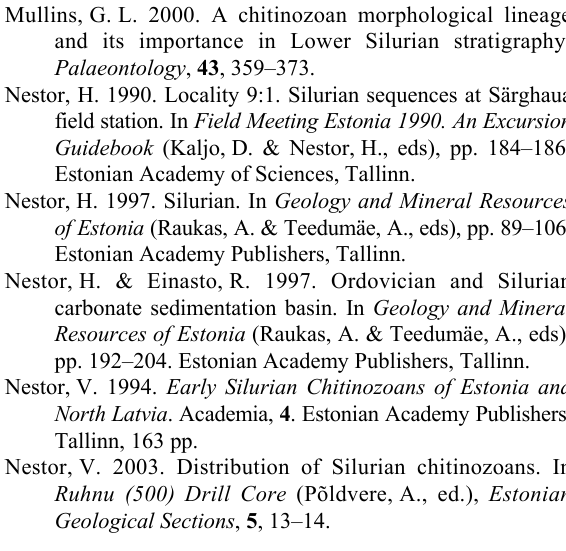
C. tuba tsoonini. Proovid tasemest 13,86 m kırgemale j(cid:228)(cid:228)vast l(cid:228)bilıikeosast kitiinikuid ei sisaldanud.